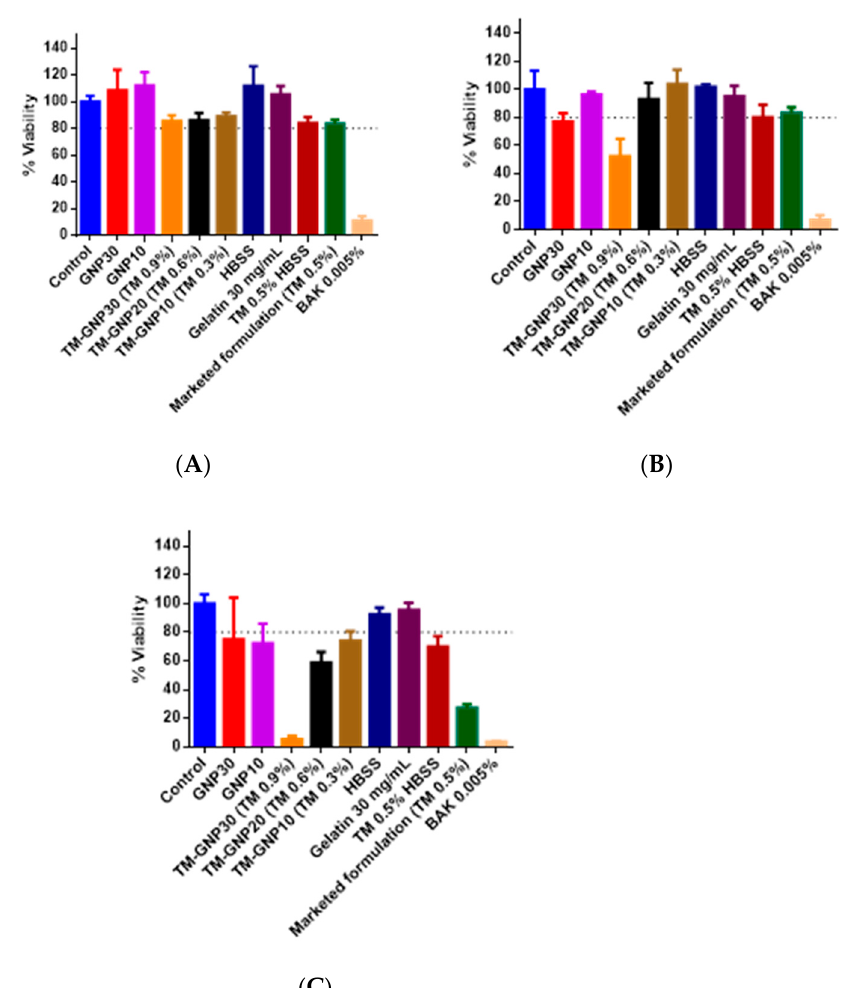
Figure 3. Human corneal cells (HCEpiC) viability at different exposition times (1 h ( A ), 4 h ( B ) and 24 h ( C )). Negative control: cell culture media; GNP30, GNP20 and GNP10 entail unloaded gelatin nanoparticles at 30, 20 and 10 mg/mL, respectively. TM-GNP30, TM-GNP20 and TM-GNP10 indicate timolol maleate gelatin loaded nanoparticles at 30 mg/mL, 20 mg/mL and 10 mg/mL (equivalent percentage of timolol maleate shown in brackets: 0.9%, 0.6% and 0.3%). HBSS: Hank’s balanced salt solution; gelatin 30 mg/mL dissolved in HBSS (raw material), Timolol maleate 0.5% dissolved in HBSS (raw material), marketed formulation (0.5%) and positive control BAK 0.005%.